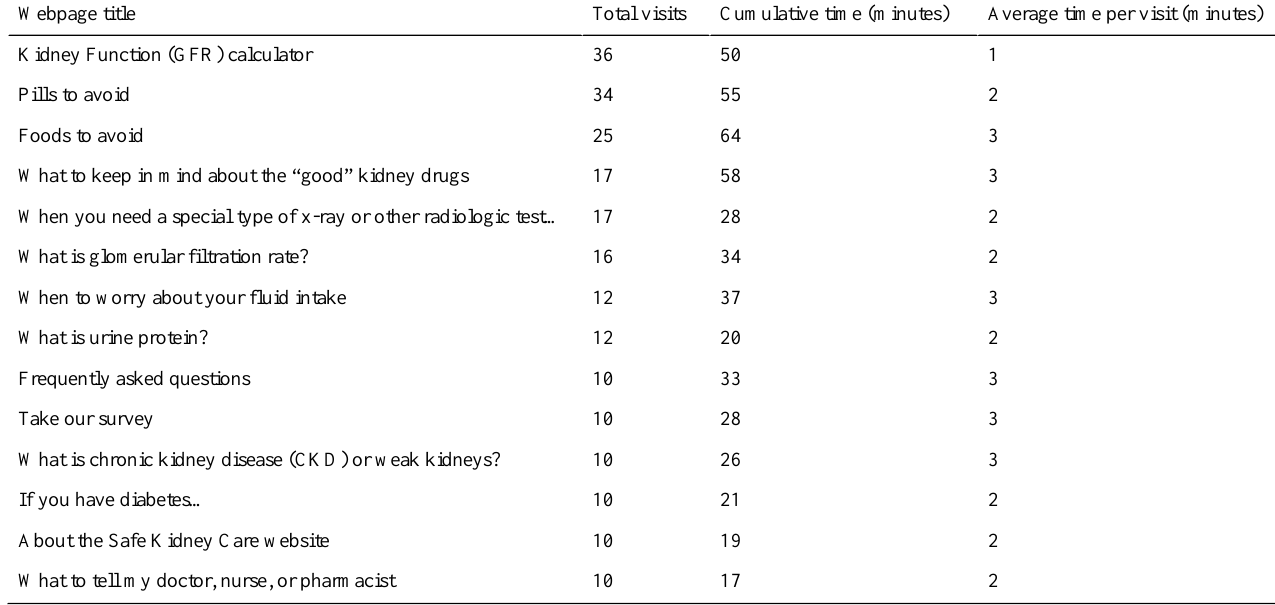
Table 2. Most frequently visited SKC